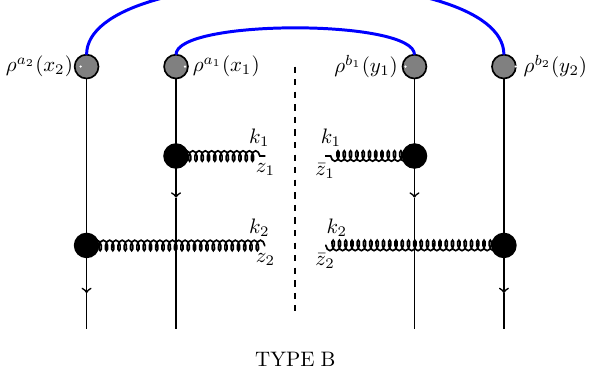
Fig. 3 Diagrams of type B, Eq. (13)